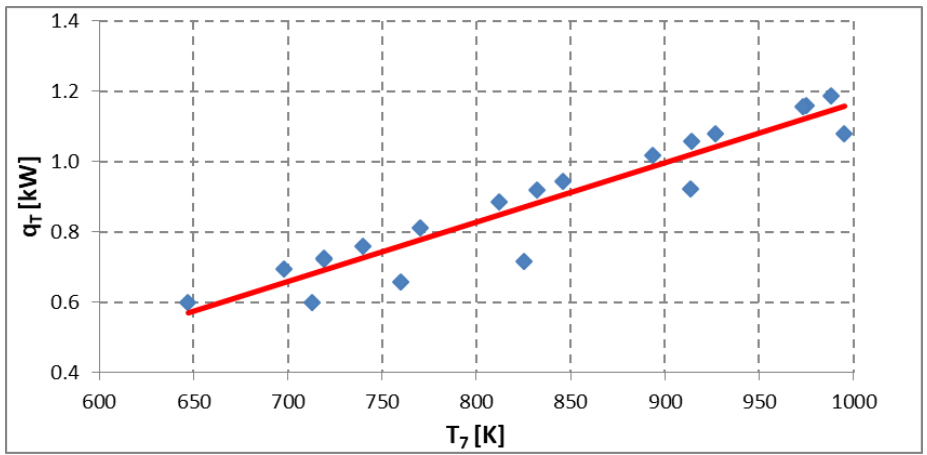
Figure 2. Exchanged heat as a function of turbine input gas temperature.